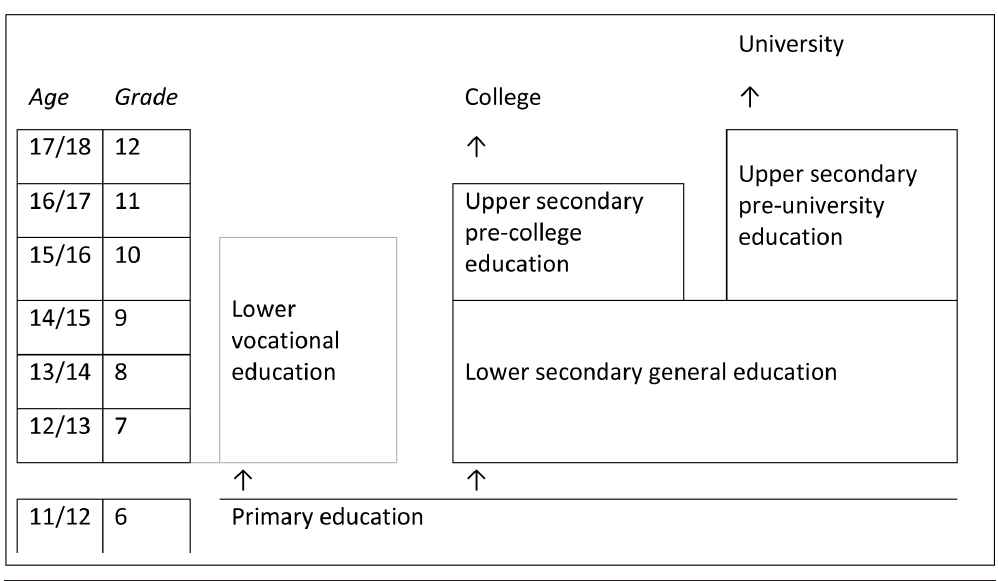
Figure 1: The Dutch educational system from Grade 6 (after primary education, students are tracked according to